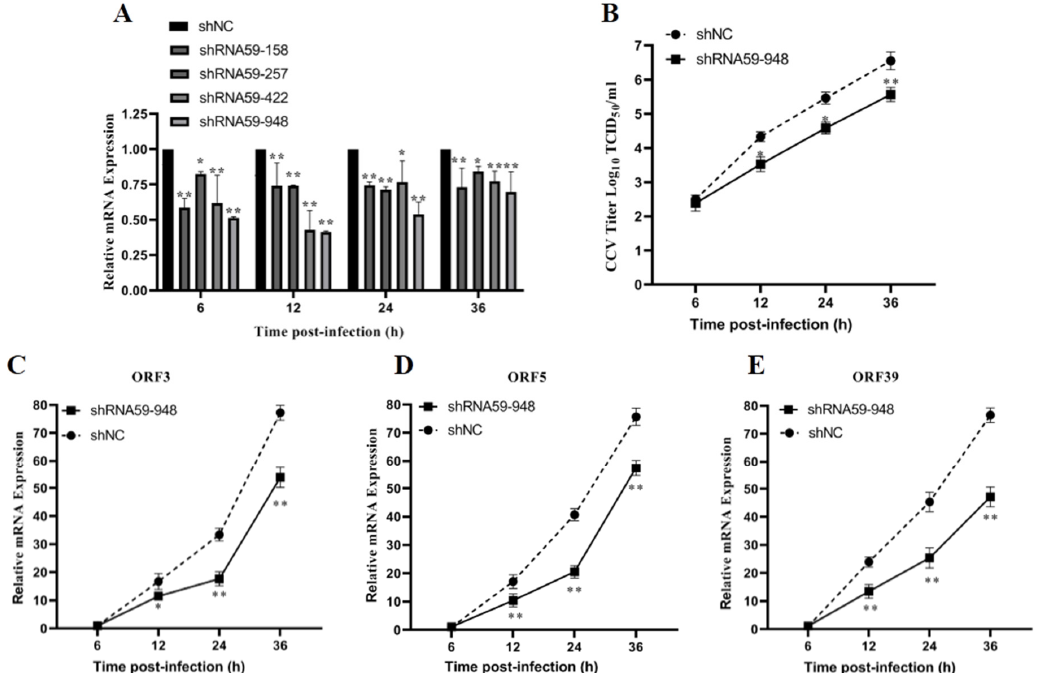
Figure 5. ORF59 silencing affects production of CCV infectious virus particles in CCO cells. ( A ) Relative gene expression of CCO cells after transfecting different shRNA plasmids. RT-PCR was used to determine the genome copy number at 6, 12, 24, and 36 hpi after transfecting plasmid shRNA59-158, shRNA59-257, shRNA59-422, and shRNA59-948. The data were compared with shNC group. ( B ) Measurement of CCV virus titer after ORF59 silencing. The titers of CCV in the CCO supernatant were calculated by the method described by Reed–Muench at the indicated time. ( C – E ) The progeny viruses within the cell supernatants at 36 hpi (shRNA59-948 and shRNA-NC) were collected to infect CCO cells, and viral gene expression (ORF3, ORF5, and ORF39 genes) of progeny viruses was determined using qRT-PCR at 6, 12, 24, and 36 hpi. The relative fold change was measured using qRT-PCR normalized against 18S rRNA, and data were compared with the 6 hpi group. CCV, channel catfish virus; CCO, channel catfish ovary; qPCR, quantitative real-time PCR; hpi, hours post-infection; qRT-PCR, quantitative real-time reverse transcription PCR. Values represent mean ± SD (n > 3) for experiments performed in triplicate. * p < 0.05, ** p <